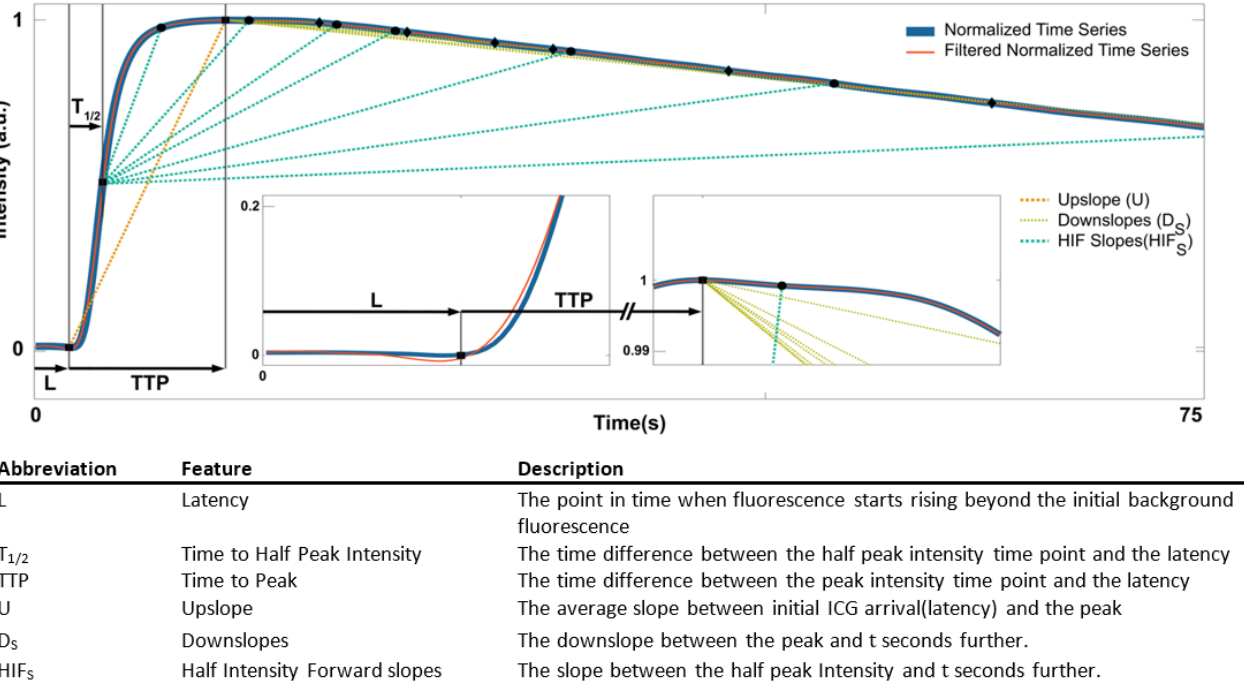
Figure 3. Feature extraction. The normalized mean intensity of ICG taken over ROIs is plotted for the first 75 s (blue). The time series was smoothed using a Savitzky – Golay filter of order 3 with window length 31 (red). The insets show enlarged curve regions to visualize the characteristics and relationships of the features. S = {2, 4, 5, 6, 8, 10, 12, 14, 16, 18, 20, 23, 25, 30, 35, 40, 50, 60, 70, 80}.